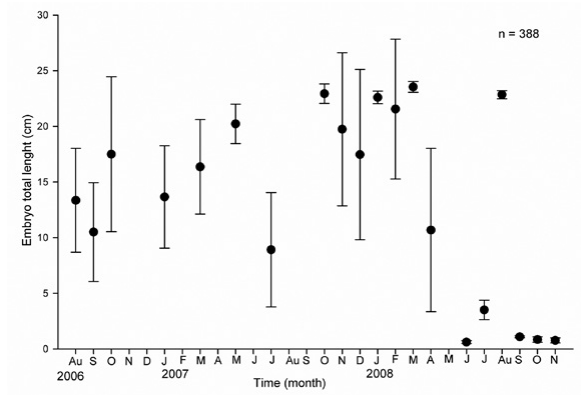
Fig. 4. – Average length (centre point) and standard deviation (error bars) of Mustelus higmani embryos captured by the artisanal fishery of Margarita Island, Venezuela from 2006 to 2008.